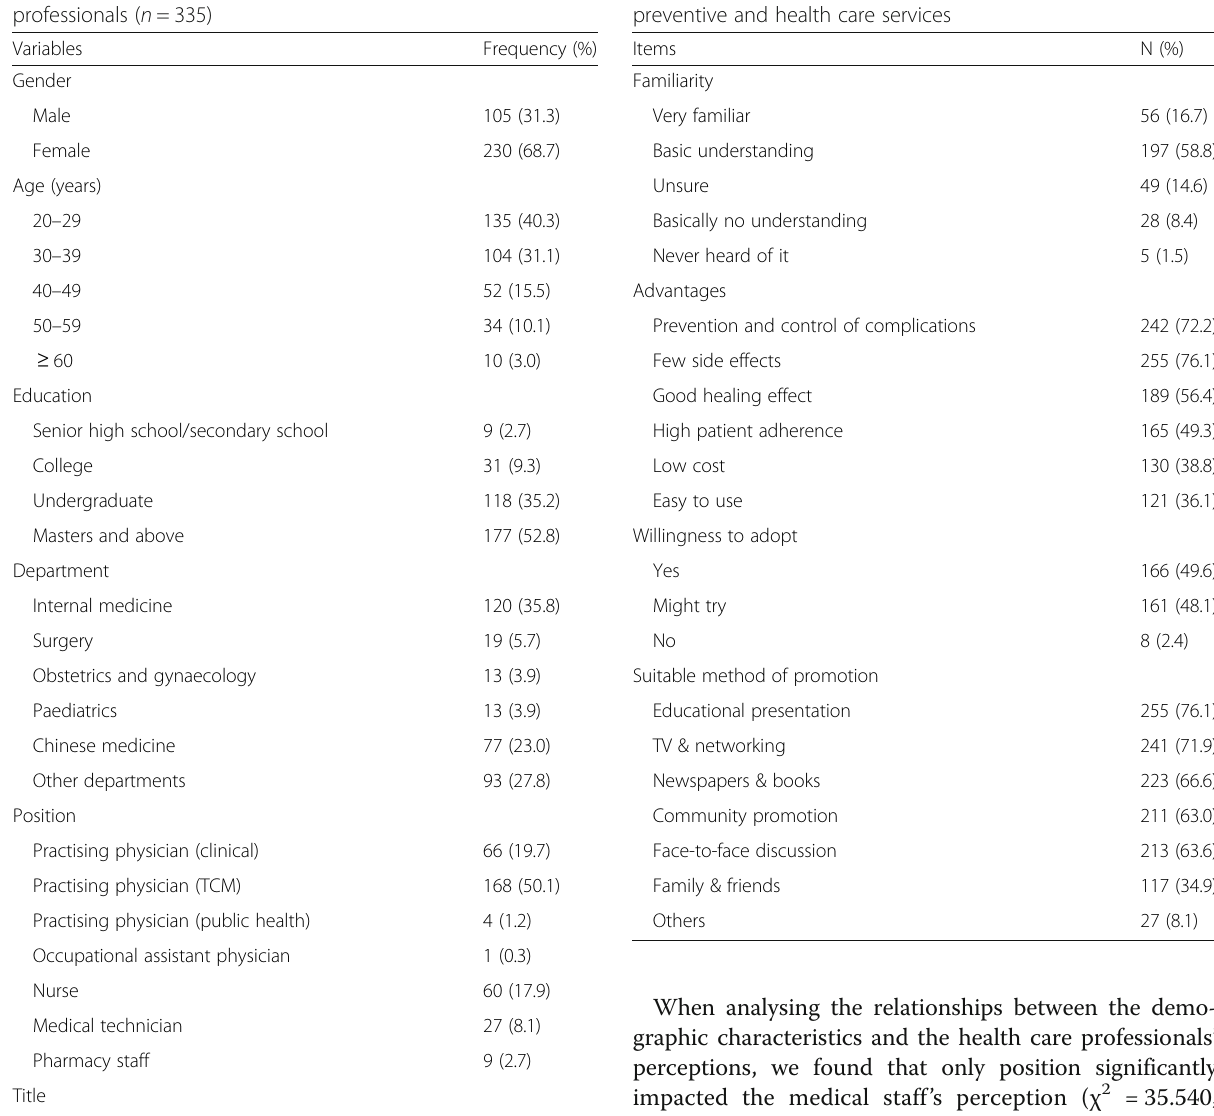
Table 1 Demographic characteristics of the health care Table 2 Health care professionals ’ perception of